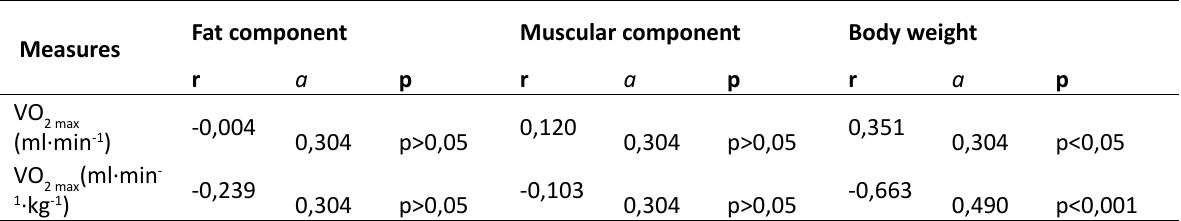
Table 6. Interrelation of the maximum oxygen consumption with body weight and component body structure of women (balanced